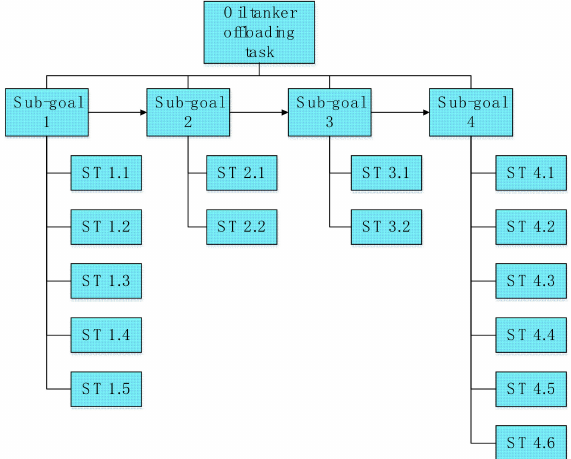
Figure 9. HTA structure of the oil tanker offloading